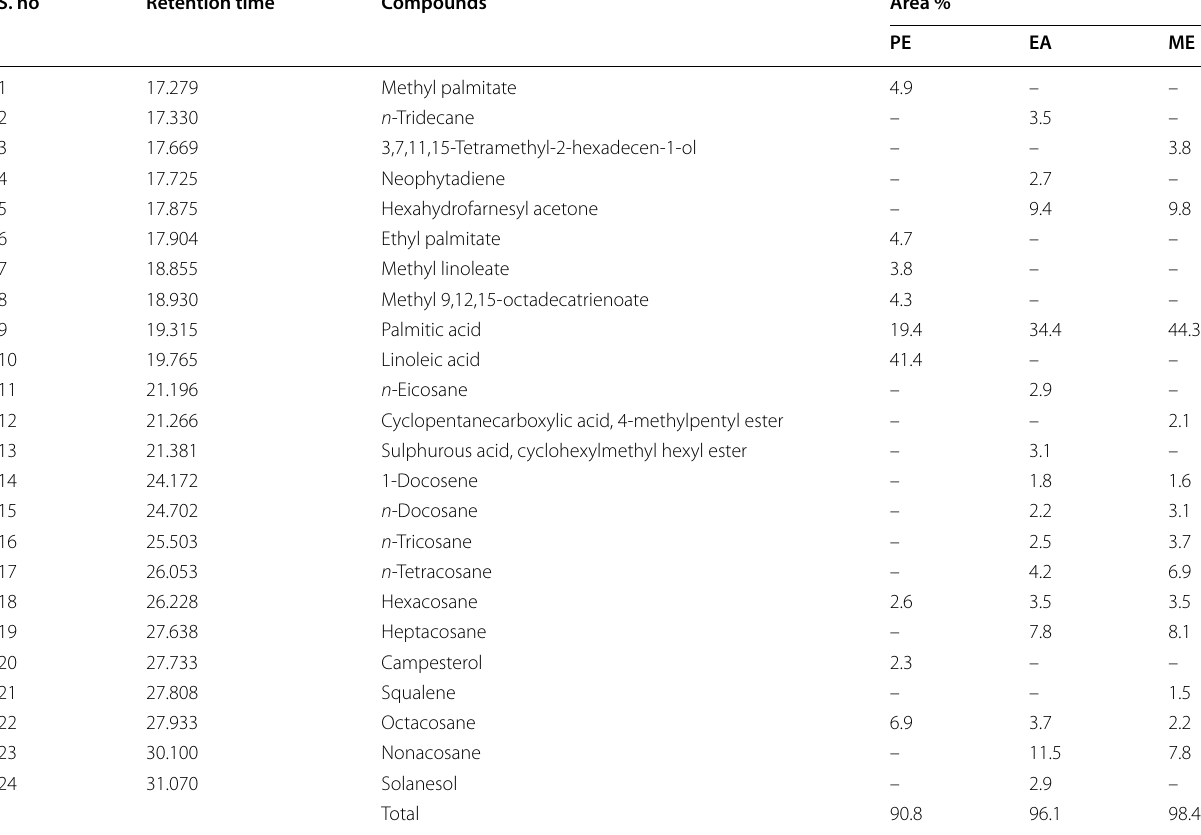
PE petroleum ether, EA ethyl acetate, ME